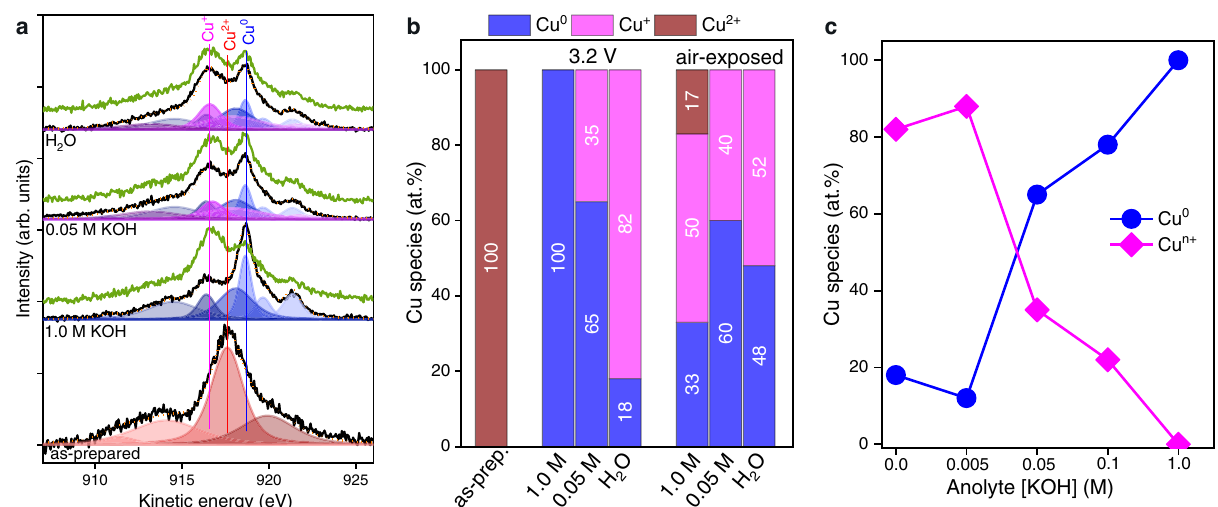
Fig.5|XPSanalysisofsurfacespeciation.a CuLMMAugerspectraofas-prepared sampleandsamplesmeasuredat3.2Vusingdifferentanolyteconcentrations(H 2 O, 0.05M and 1.0M KOH). Black lines are raw data obtained without air exposure, green lines are re-measurements following ca. 30min. air exposure, and shaded